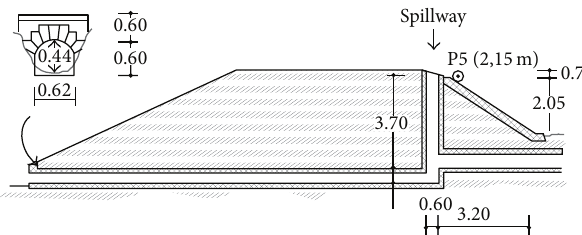
Figure 10: Transverse cross section of the embankment showing a spillway at 404 m and location of profile